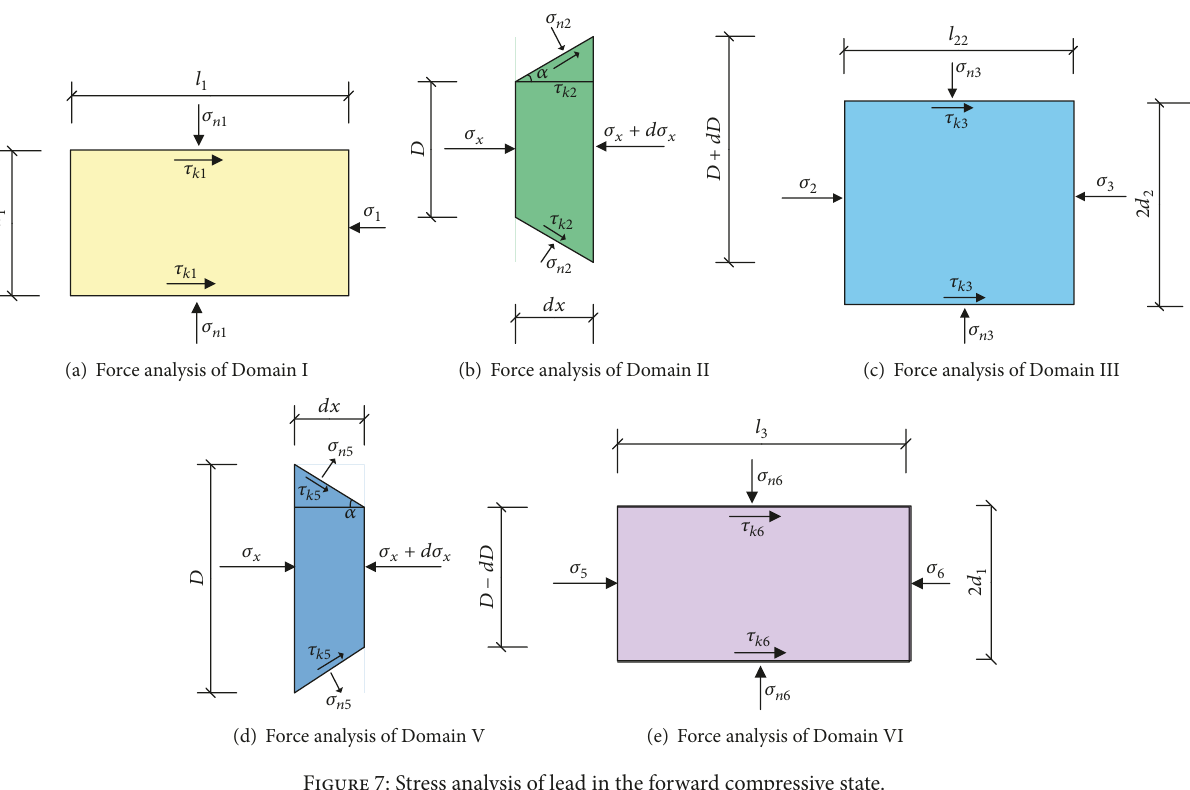
Figure 7: Stress analysis of lead in the forward compressive